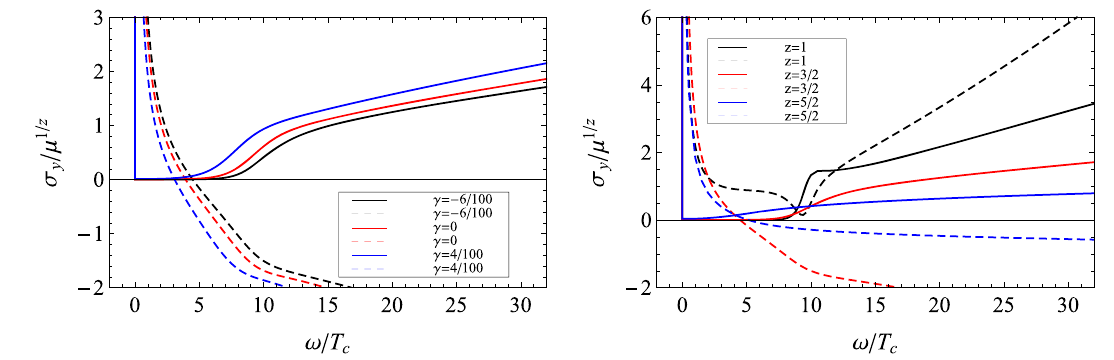
≈ 1 as a function of the frequency for fixed z = 3 T c 2 with z = 1 (black), z = 3 100